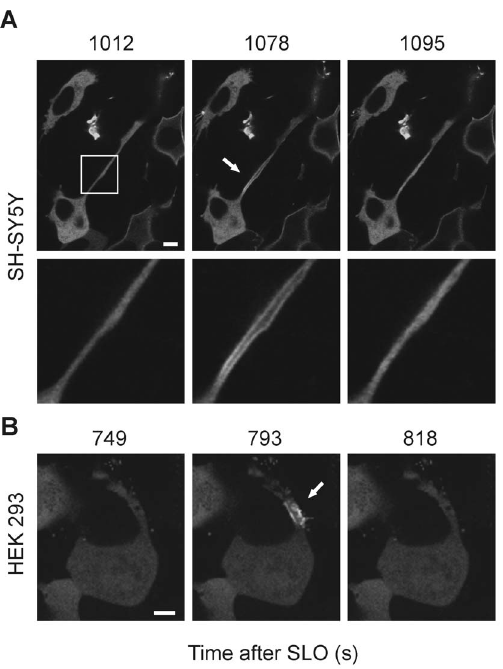
Figure 4. The plasmalemmal repair of SLO pores occurs in lysosome-free cellular protrusions. ( A,B ) SLO-induced plasmalem- mal translocation/cytoplasmic back-translocation of annexin A1-YFP marks the successful elimination of the SLO-pores in ( A ) a neurite of a SH-SY5Y cell or in ( B ) a cytoplasmic protrusion of a HEK 293 cell. Arrows denote the plasmalemmal translocation of annexin A1 (plasmalemmal permeabilization). Magnified images of the squared region are shown in ( A ). Magnification bars=5 m m.